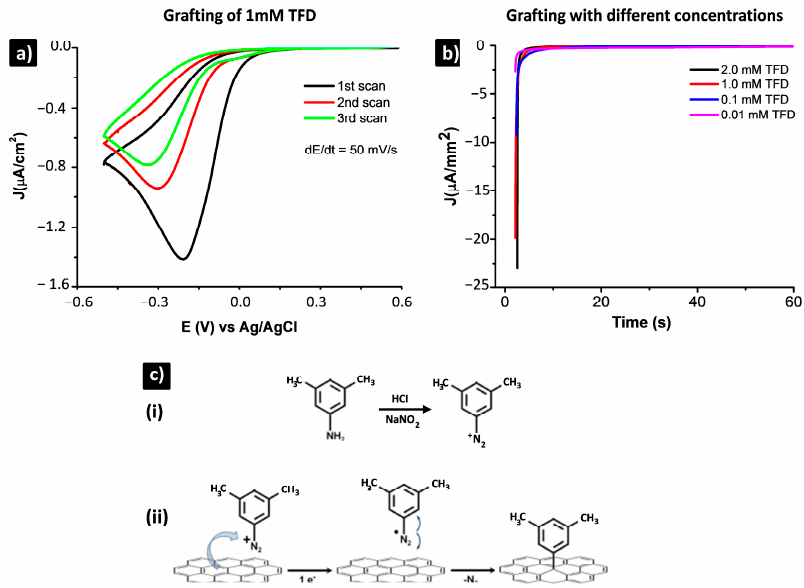
Figure 1. ( a , b ) Cyclic voltammogram results illustrating the electrografting of 1mM 3,5-TFD on HOPG exhibit a well-defined cathodic peak at E = − 0.21 V vs. Ag/AgCl assigned to the reduction of 3,5-TFD molecule to its radicals; ( b ) concentration-dependent electrochemical behavior of 3,5-TFDvia CA approach electrografted at E = − 0.3 V vs. Ag/AgCl for 60 s; ( c ) mechanisms of ( i ) the in-situ formation of 3,5-TFD cation from its corresponding aniline, and ( ii ) electrografting of this molecule on graphene-like surface.